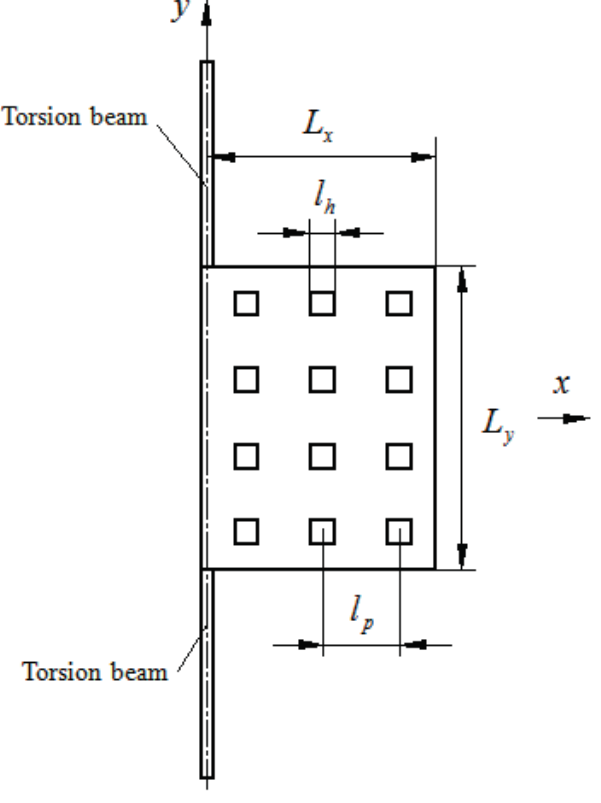
Figure 3. Top view of the perforated torsion microplate (type